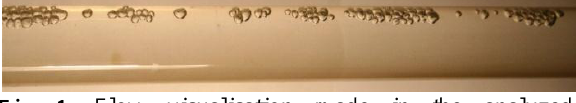
Fig. 1. Flow visualisation made in the analyzed experiment.